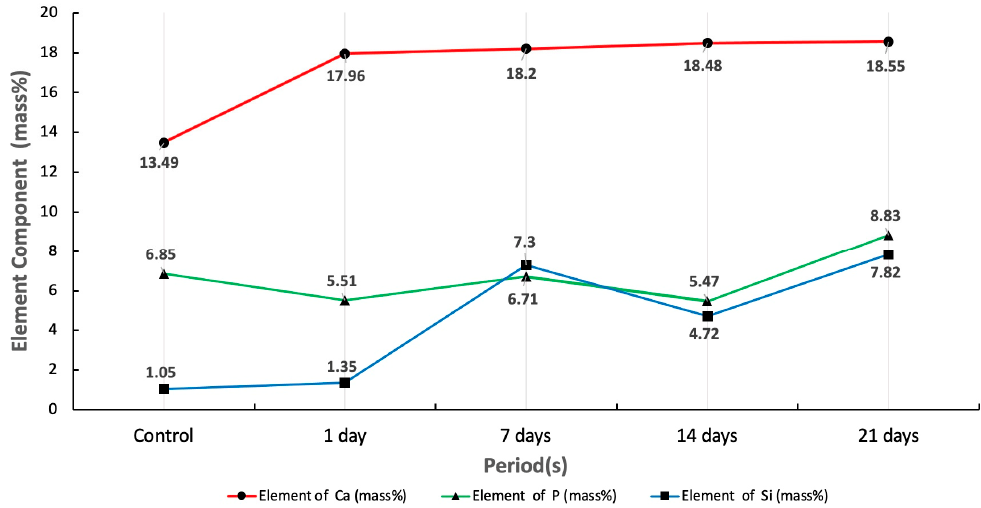
Figure 3. Evaluation of Ca, PO and Si elements before and after soaking into SBF for 1, 7, 14, and 21 day(s).